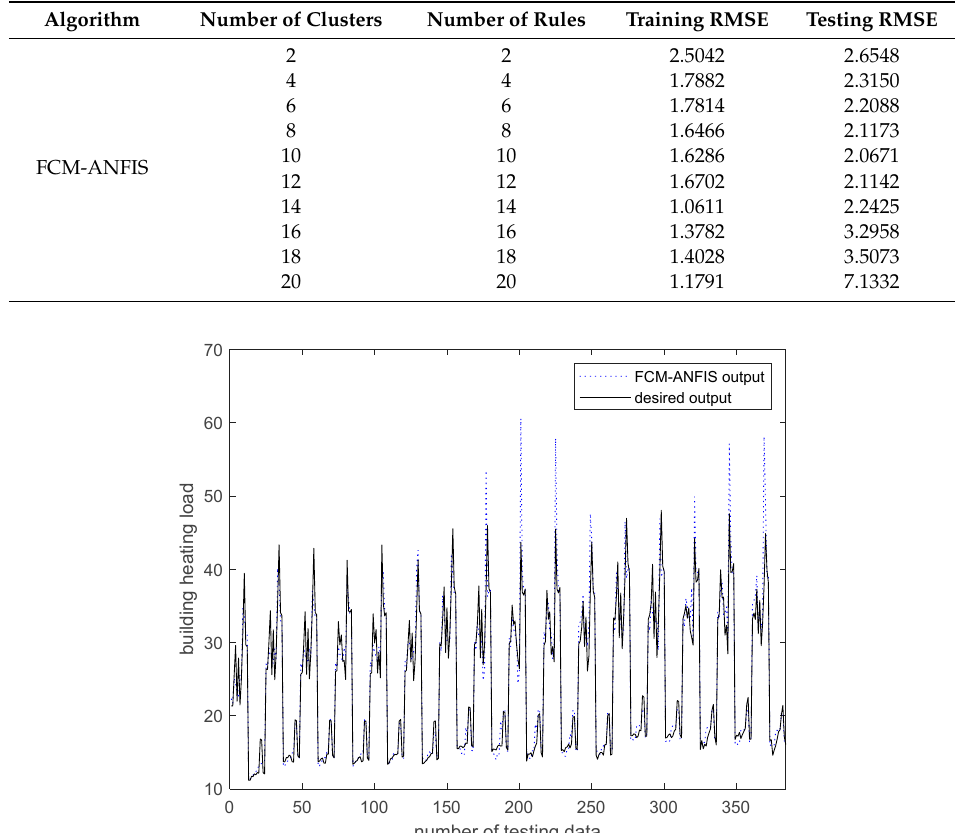
Table 2. Prediction experiment results from FCM-clustering-based ANFIS.